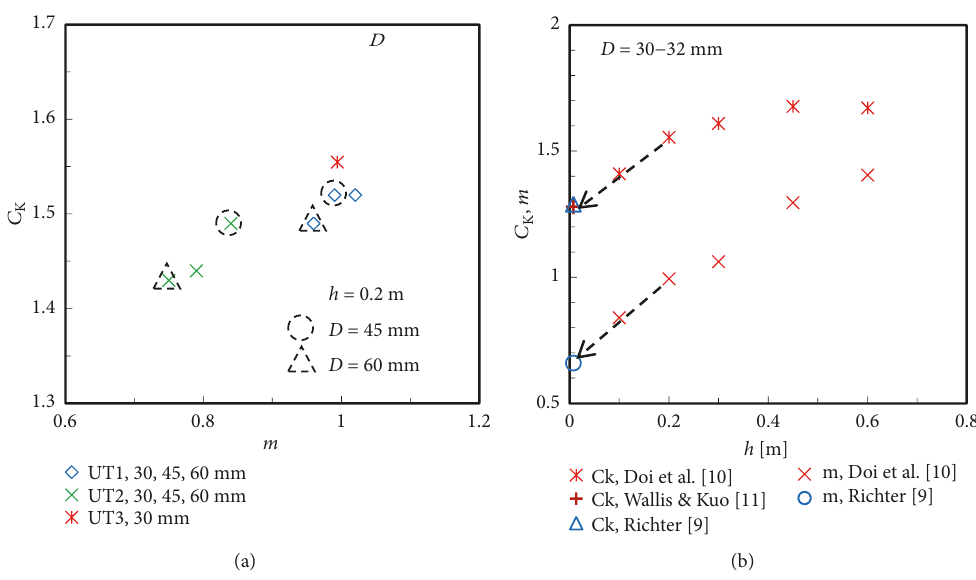
Figure 4: Effects of (a) upper tank by Doi et al. [10] (UT1-UT3: cf. Figure 2(d)) and (b) water level h on 𝐶 K and m .